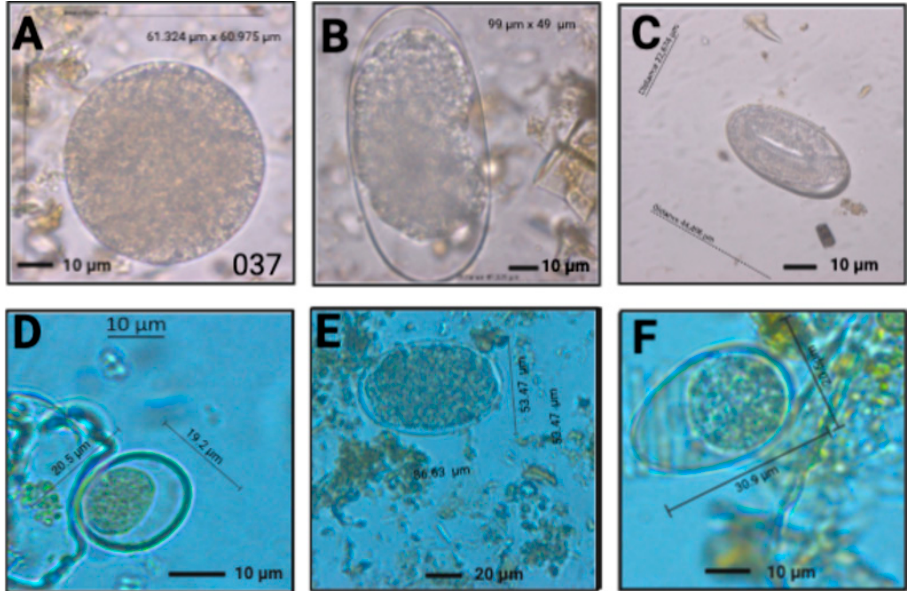
Figure 4. Eggs and cysts found in E. caballus and B. taurus . E. caballus : Buxtonella sulcata ( A ), Strongylus spp. ( B ) Strongyloides spp. ( C ), Eimeria bovis . ( D ), Trichostrongylus spp. ( E ); Eimeria zuernii ( F ).